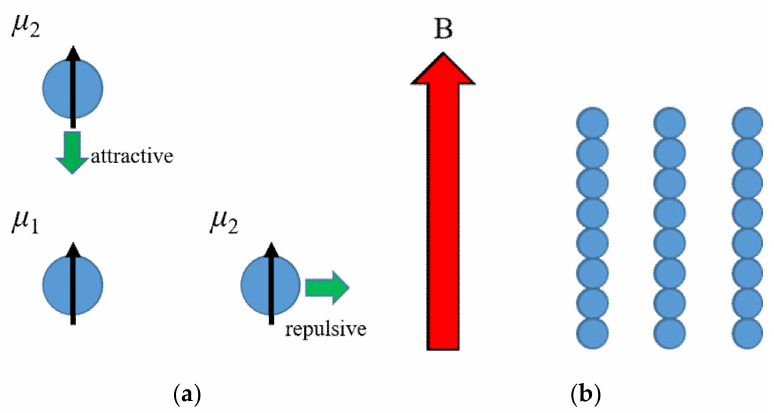
Figure 9. Dipole–dipole interaction acts on the adjacent magnetic dipoles. ( a ) Depending on the arrangement between the dipoles, the direction of the force is di ff erent. ( b ) The column structure is formed under a magnetic